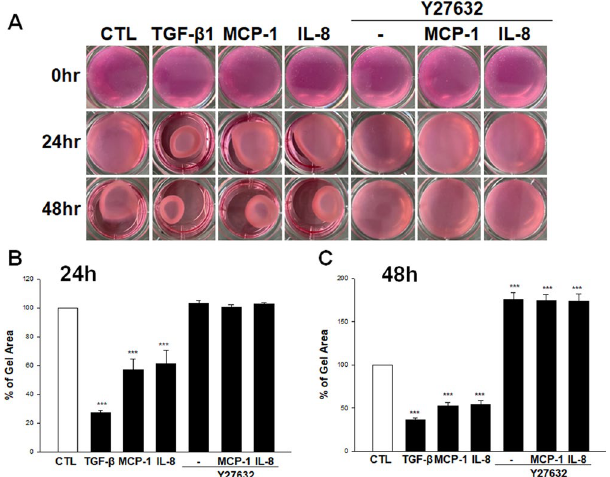
Figure 2. The effect of MCP-1 and IL-8 on human TM cell contraction using collagen gel contraction assay. After serum-starvation for 24 h, primary TM cells obtained from ScienCell Research Labs were embedded in collagen gels and treated with MCP-1 (100 ng/ml), IL-8 (100 ng/ml) or TGF-β1 (15 ng/ml) alone or in the presence of Rho-kinase inhibitor-Y27632 (10 µM for 30 min pretreatment) or with inhibitors alone for 24 h and 48 h. ( A ) At 24 h, collagen gels were significantly contracted by MCP-1, IL-8, and TGF-β1 treatment ( P < 0.001) compared with the control group. However, pre-treatment with Y-27632 (10 µM) prevented the contraction by MCP-1 and IL-8. ( B ) After treatment with MCP-1, IL-8 or TGF-β1 for 48 h, MCP-1, IL-8, and TGFβ1 induced a further increase in the contraction of gels compared with the control group ( P < 0.001, all), while the pre- treatment with Y-27632 significantly decreased contraction compared with the control group ( P < 0.001) ( C ). The results of three independent experiments are expressed as the mean ± SEM, and one-way ANOVA with Dunnett’s multiple comparison was done. Culture wells were photographed (bottom) and area of gel matrices were measured using Image J software. *** P <